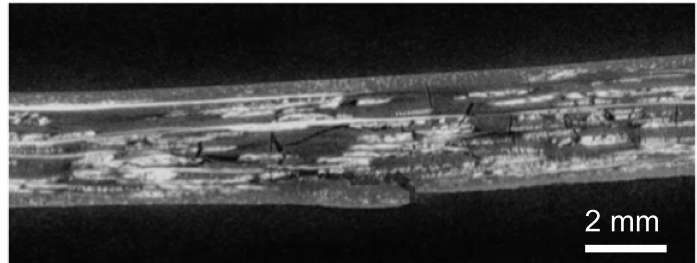
Figure 11. Micro computed tomography ( µ CT)-scan of damaged discontinuous glass fiber SMC specimen exposed to bending